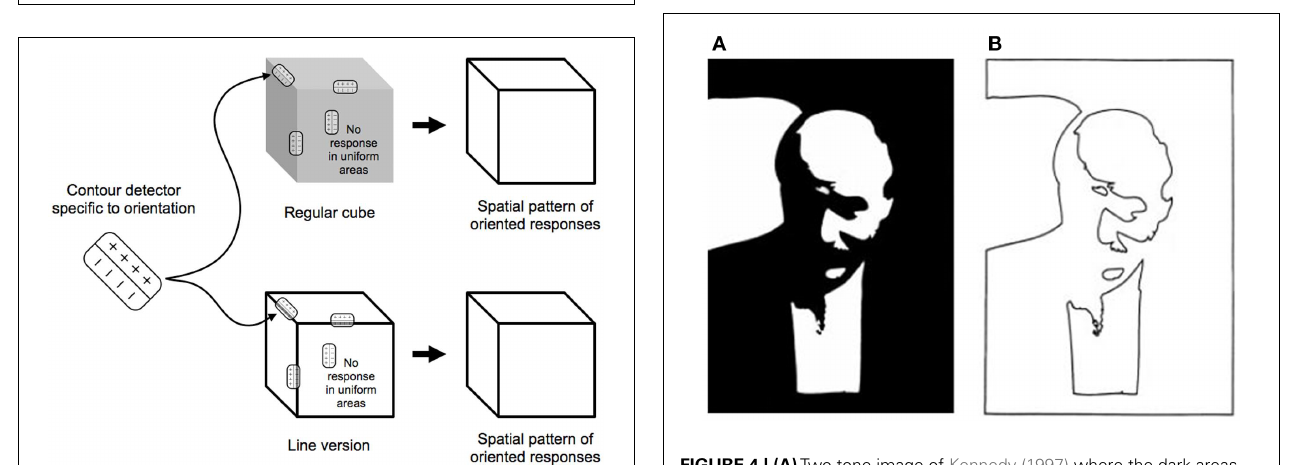
FIGURE 4 | (A) Two-tone image of Kennedy (1997) where the dark areas could be dark pigment or dark shadow.The face can be recovered only if the shadows are correctly identified. (B) A line version of the same contours is unrecognizable.The polarity information required for finding shadows is lost.The shadow boundaries can no longer be discounted and are taken as object contours that form meaningless shapes unrelated to the